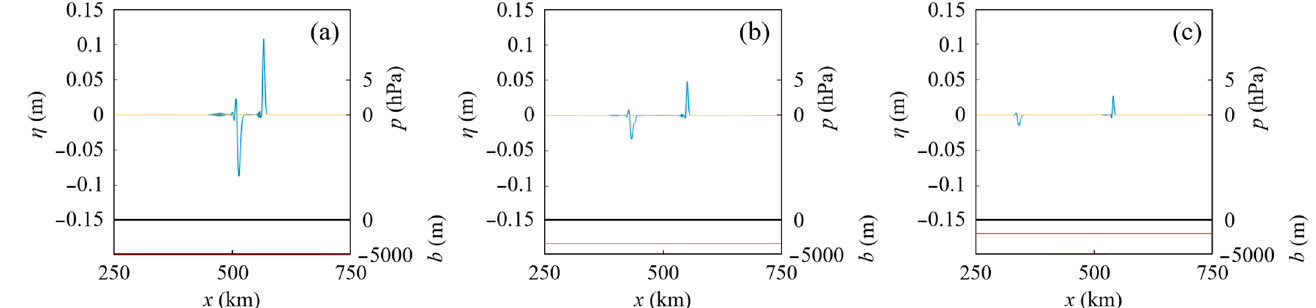
Figure 9. Water surface profiles at t = 1610 s for different still-water depths h in Case G, in which x 1 = 55 km in Figure 1. The blue, orange, and red lines indicate the water surface displacement η , atmospheric pressure p , and seabed position b , respectively. ( a ) h = 5000 m. ( b ) h = 3500 m. ( c ) h = 2000 m.